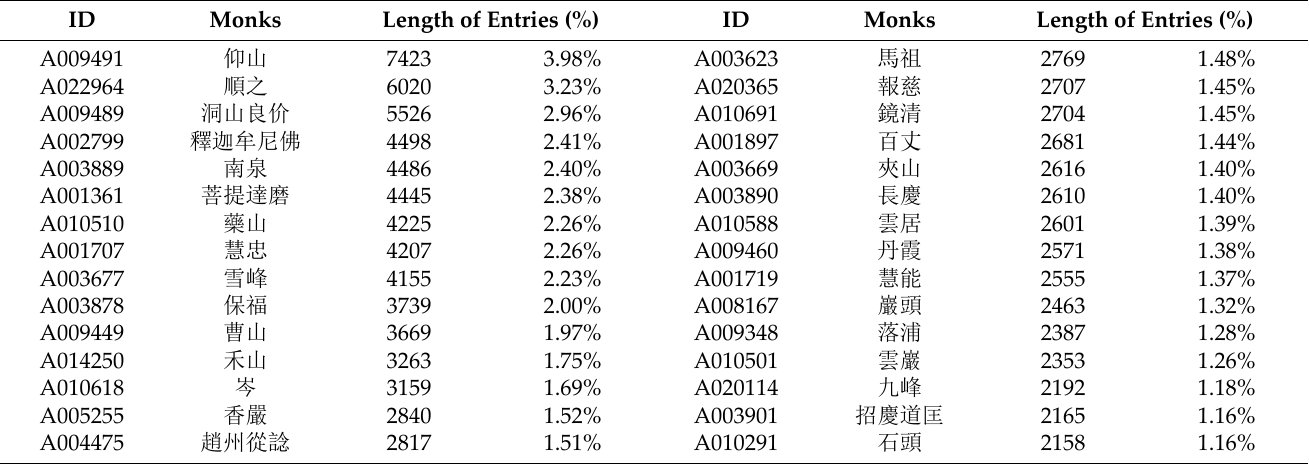
Table 3. Figures with the longest entries in the ZTJ (in characters). Scope: 30